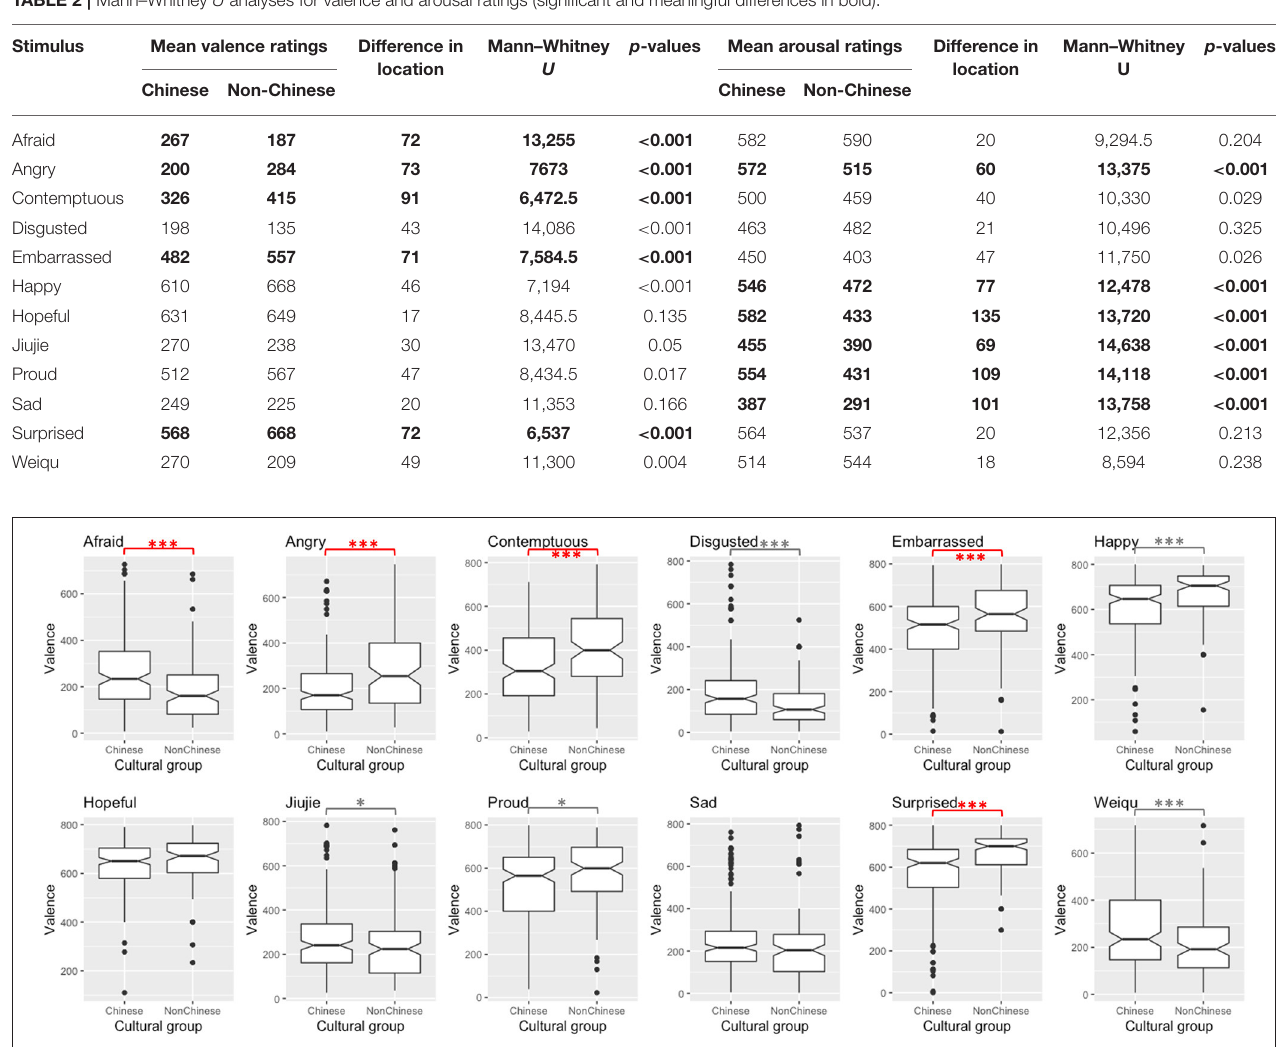
FIGURE 3 | Differences in Chinese and non-Chinese participants’ valence ratings per stimulus (***significant at 0.01 level, *significant at 0.05 level, significant and meaningful differences in red, significant and reaching meaningfulness in dotted red, significant but unmeaningful differences in